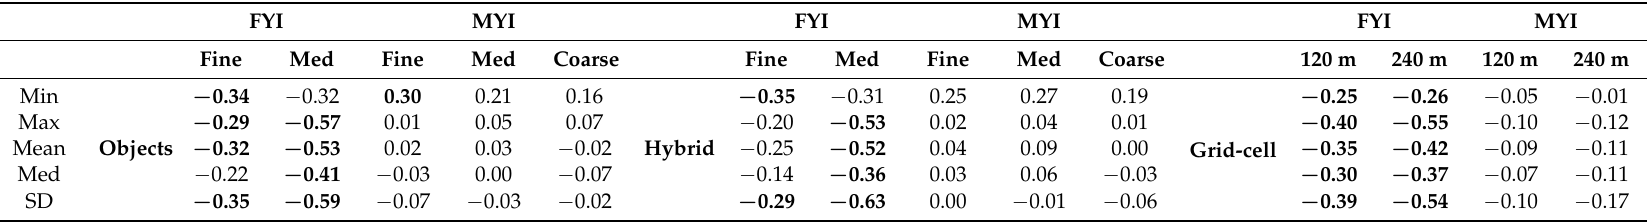
Table 3. Spearman correlation coefficients (r s ) between metrics of winter sea ice roughness and spring f p for FYI and MYI at fine, medium (med) and coarse spatial scales (object and hybrid) as well as 120 and 240 m grid-cells. Bolded values are statistically significant ( p < 0.05).